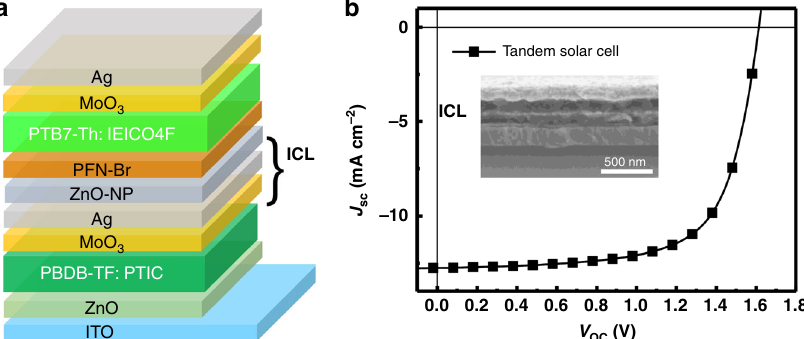
Fig. 5 Ef fi cient tandem solar cell. a Monolithic tandem architecture and b J – V curves of the tandem device under the illumination of AM 1.5G (100mWcm − 2 ). The inset is the cross-sectional SEM image for tandem